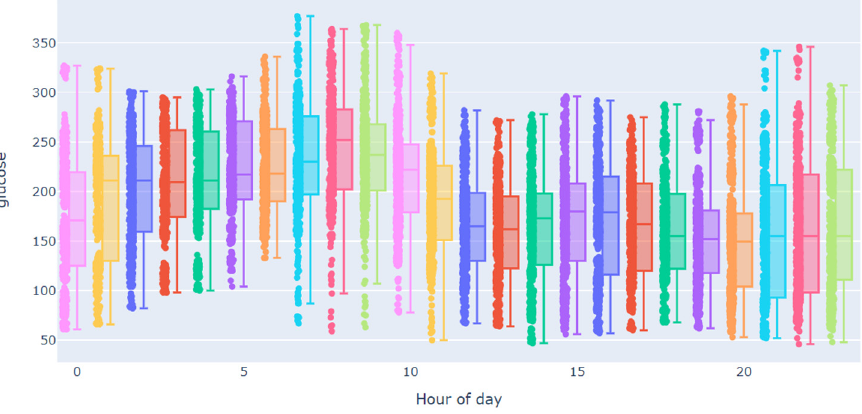
Figure 3. Boxplots of CGM by hour of the day for the training data of the subject 570. In Figure 4, boxplots of the CGM by the hour of the day for subject 540 (cid:48) s training dataset do not show a cyclic pattern. This pattern indicates stationarity of the time series. Subjects 559, 563, and 575 have similar behavior.